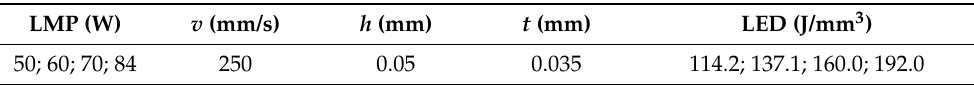
Table 1. Process parameters employed for the fabrication of SLM parts with different laser energy densities of